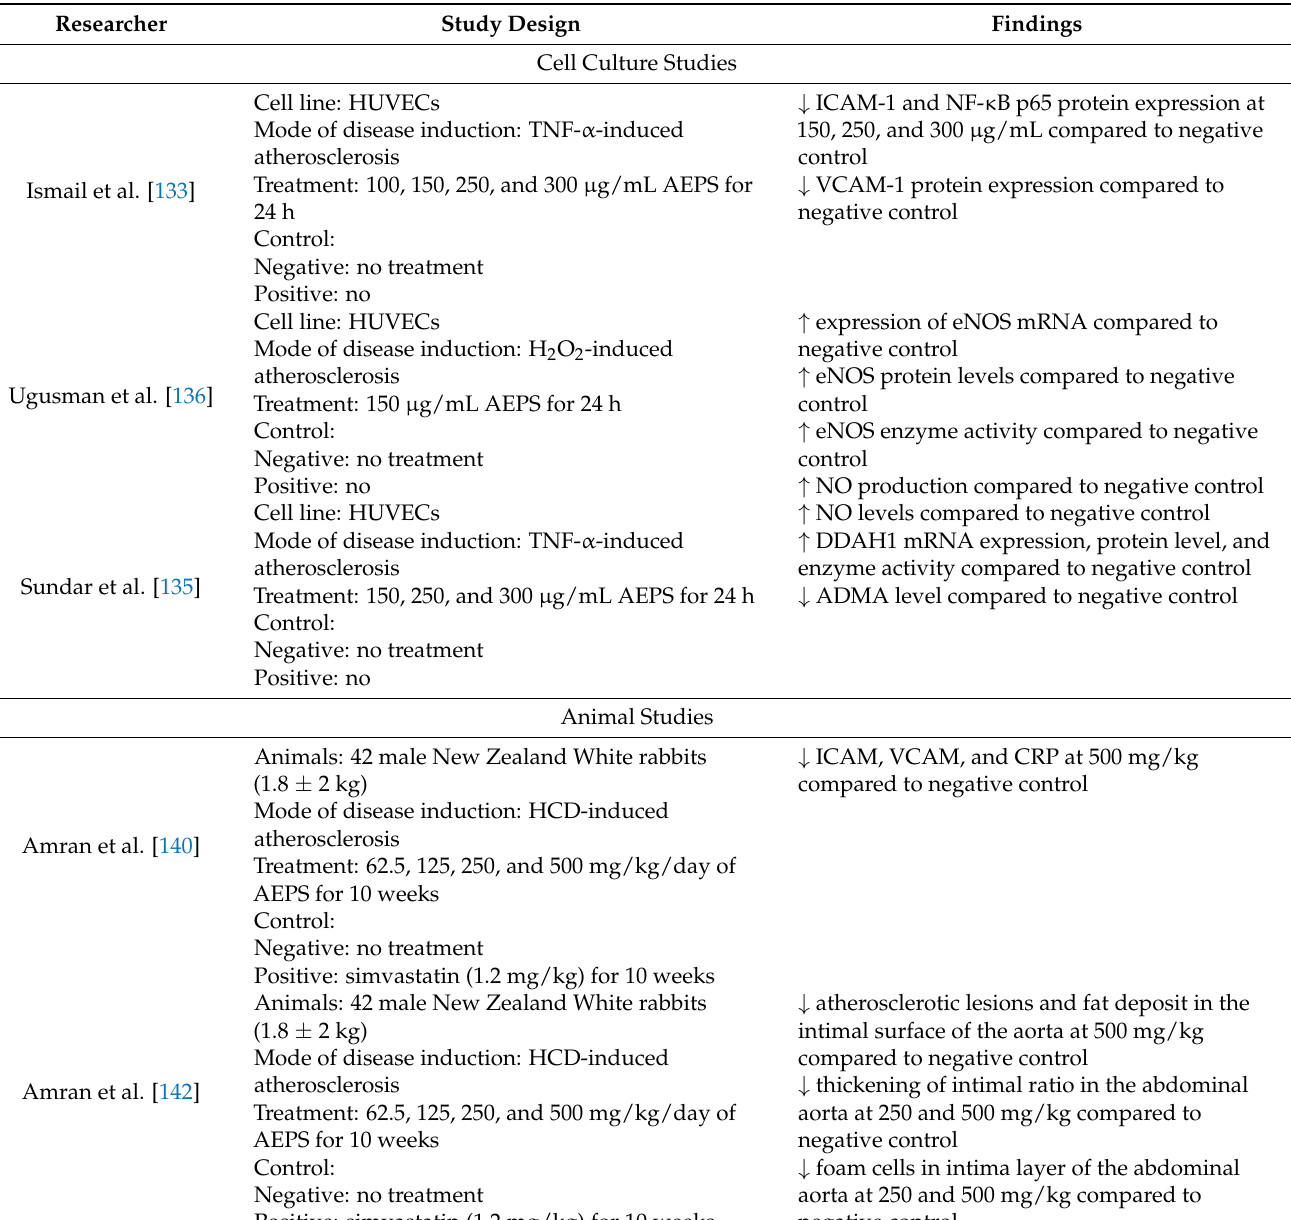
Table 2. Effect of PS on atherosclerosis and cardiovascular complications due to